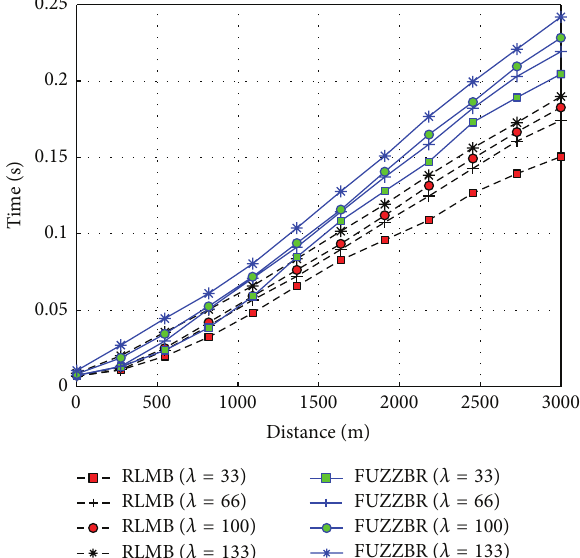
Figure 10: Number of retransmissions obtained for RLMB with 0.25 hps compared with the retransmissions obtained for two HMR (0.25 hps, 1hps) of FUZZBR when increasing the vehicles density, 𝜆 .